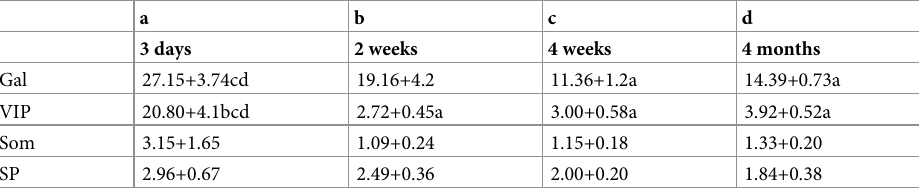
Data presented as mean +SEM. Letters indicate groups to which particular result is statistically significantly